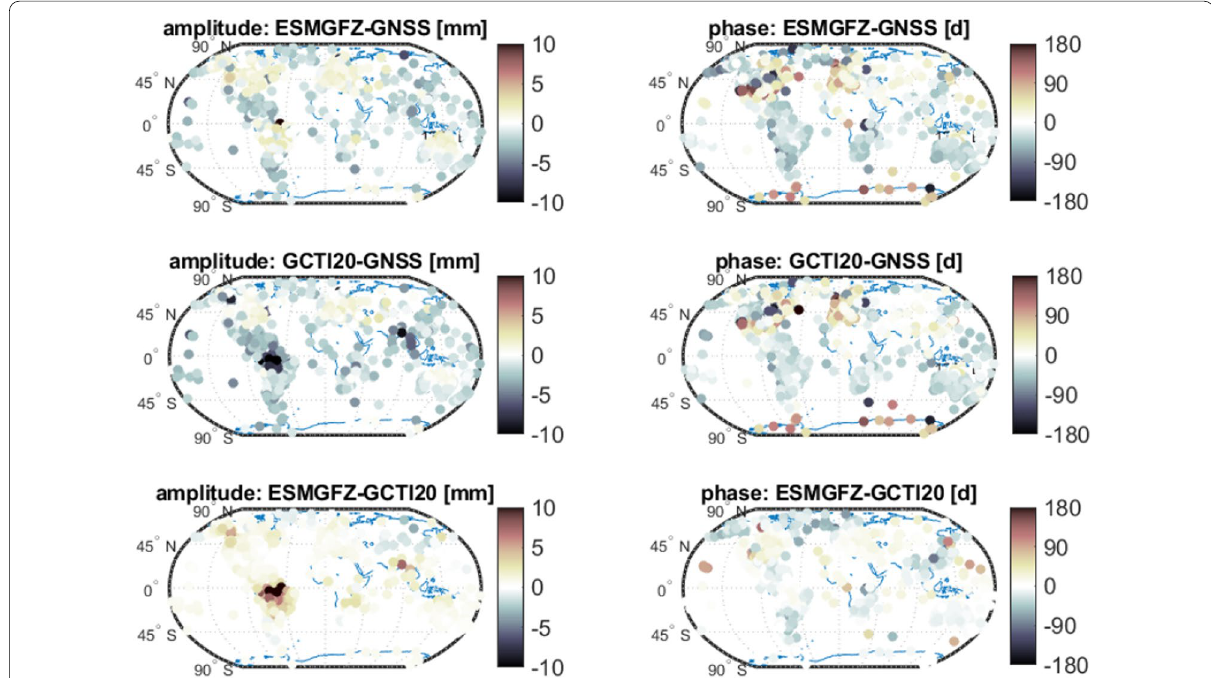
Fig. 12 Differences between the fitted annual amplitudes A 1 (left column) and annual phases φ 1 (right column) of Eq. (4) for the vertical displacements of the combined loading (NTAL stations’ height residuals. Top row: ESMGFZ minus GNSS, middle row: GCTI20 minus GNSS, bottom row: ESMGFZ minus